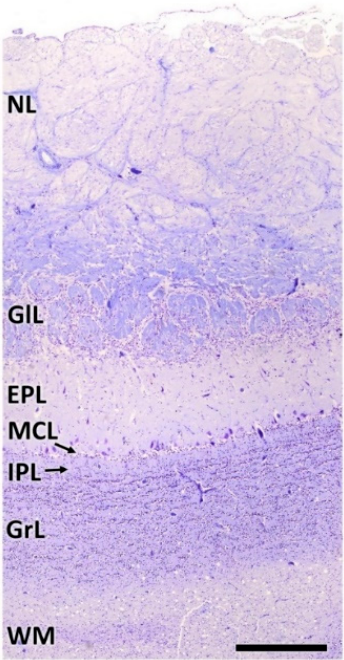
Figure 11. Lamination of the wolf OB. NL, Nerve layer. GlL, Glomerular layer. EPL, External plexiform layer. MCL, Mitral cell layer; IPL, Internal plexiform layer; GrL, Granular layer; WM, White matter. Nissl staining. Scale bar: 1 mm.